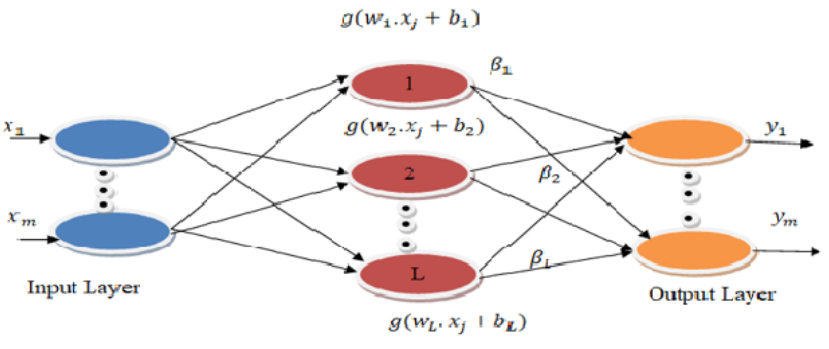
Figure 2. Schematic structure of ELM